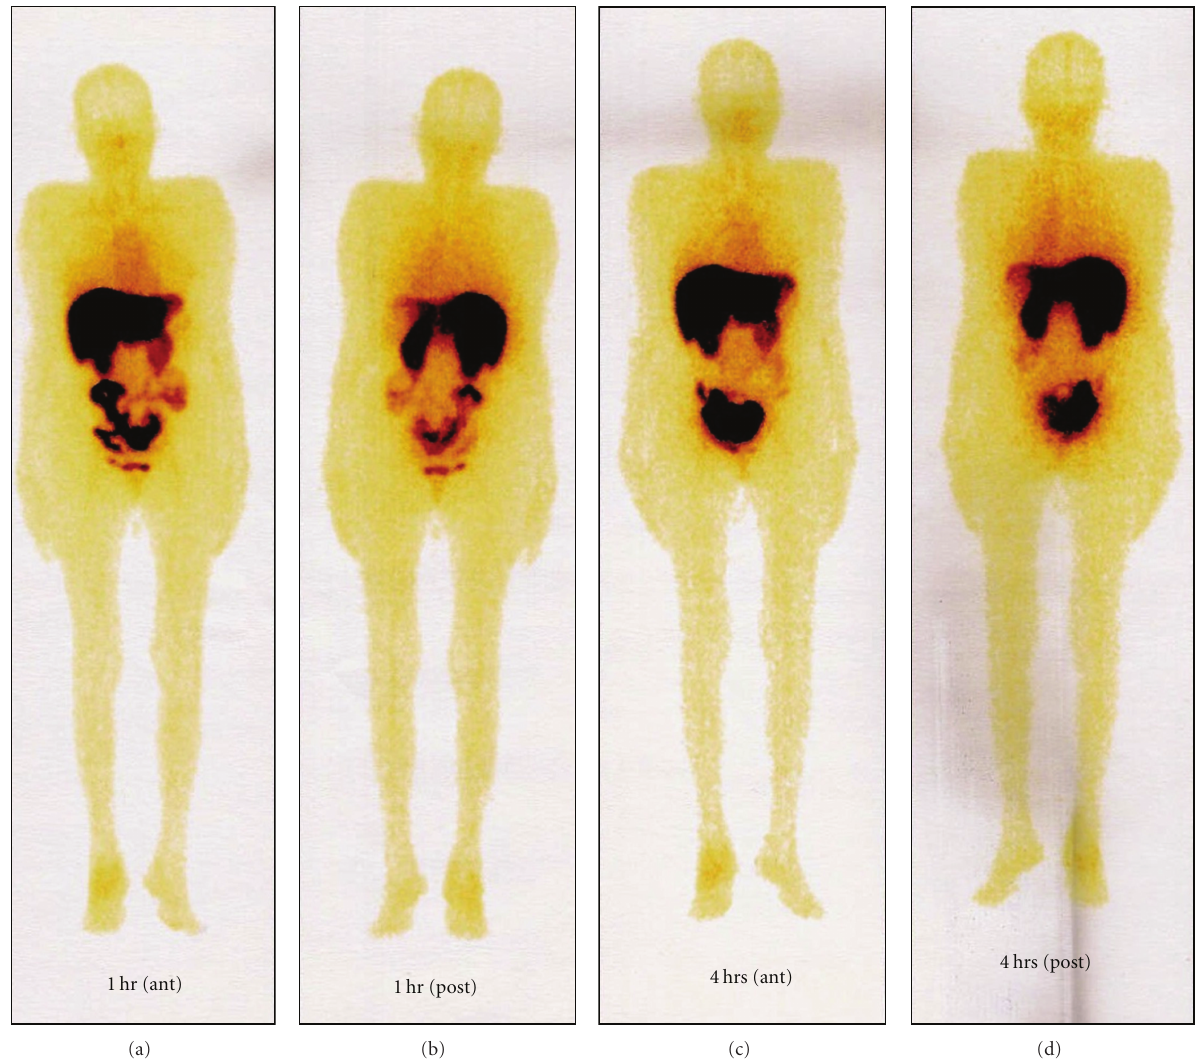
Figure 1: Whole body scan of human (healthy volunteer) showing biodistribution of 99m Tc-EMB in human at 1 hour anterior and posterior and 4 hours anterior and posterior postinjection of